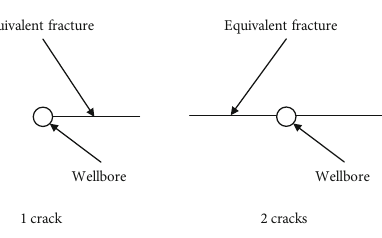
Figure 15: Sketch of a model under di ff erent amount of